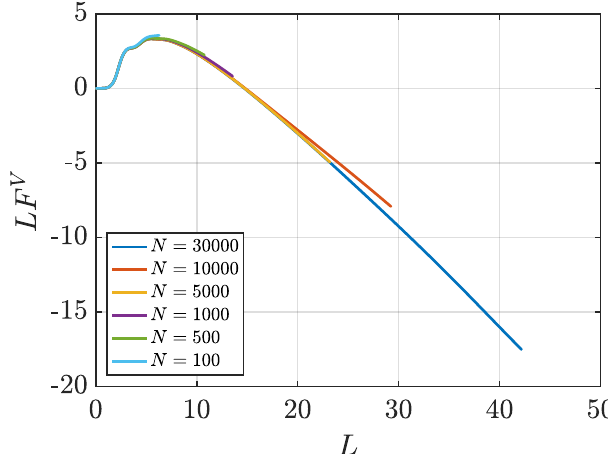
Figure 13. Surface effects of finite subvolumes multiplied by the diameter of the subvolume LF V (Equation (10)) vs. L for the LJ fluid at T = 2 and ρ = 0.4 (dimensionless units). The values of G V are computed for systems with varying number of molecules N . The used RDFs are provided in Figure